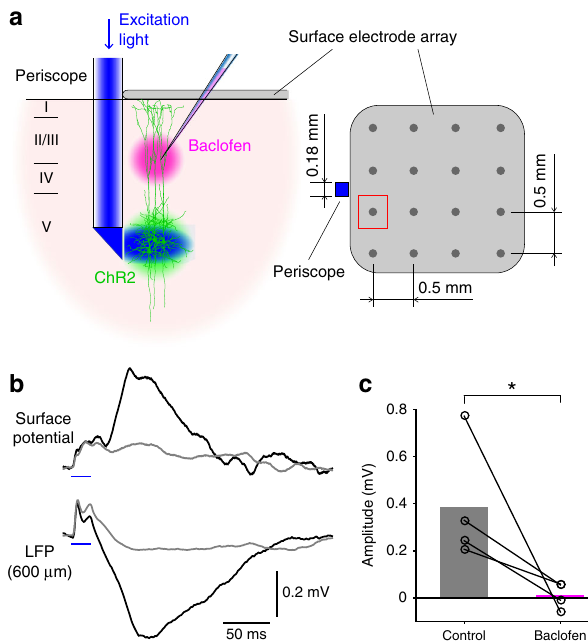
Fig. 3 Optogenetically evoked dendritic Ca 2+ spikes greatly affect surface potentials. a Schematic diagram of the experiment. Surface potentials recorded at the electrode close to the micro-periscope (marked in red ) were analyzed. b Surface potentials generated by optogenetically evoked Ca 2+ spikes ( top ) aligned with LFPs recorded at 600 μ m below the pia ( bottom ). Black and gray traces (average of 10 measurements) are with and without discernable Ca 2+ spikes, respectively. c Average surface potentials before and after application of 50 μ M baclofen into L2/3 ( n = 4, p < 0.05,